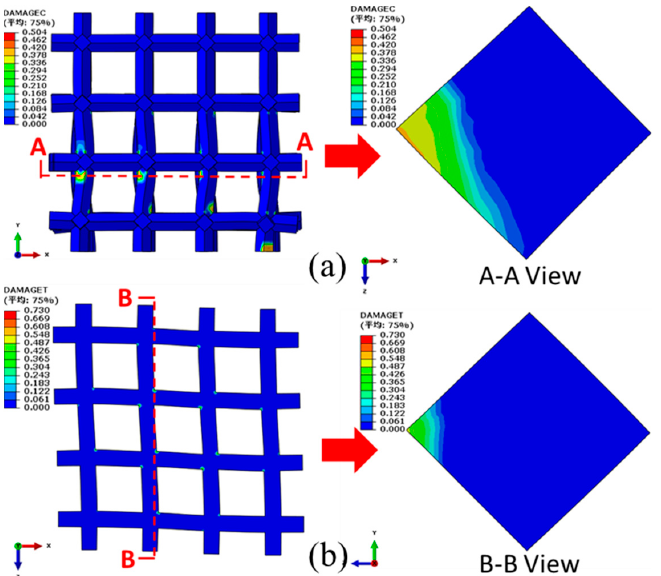
Figure 12. Damage distributions of the COF0 under the compressive displacement of 0.75 mm (uniaxial strain of 3.75%) in the y direction: ( a ) compressive damages; ( b ) tensile damages.